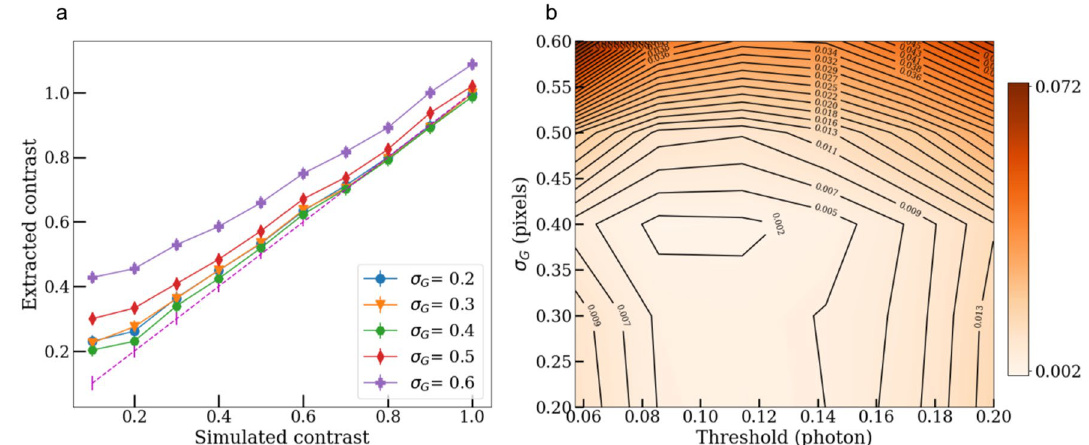
Figure 6. Extracted contrasts from the Gaussian Greedy Guess (GGG) droplet algorithm for a 1000 simulated shots. ( a ) Plot at a selected threshold of 0.1 photon with different size of charge cloud used in GGG. The violet dashed line indicates the ideal/simulated contrasts with error bars based on the r.m.s value calculated in Fig. 2b. ( b ) Surface error metric plot describing what are the optimal hyper-parameters that minimize the distance to 0.4 is smaller than the average ( σ 0.46 ) calculated in Fig. the ideal contrasts (r.m.s). The optimal σ G G = =